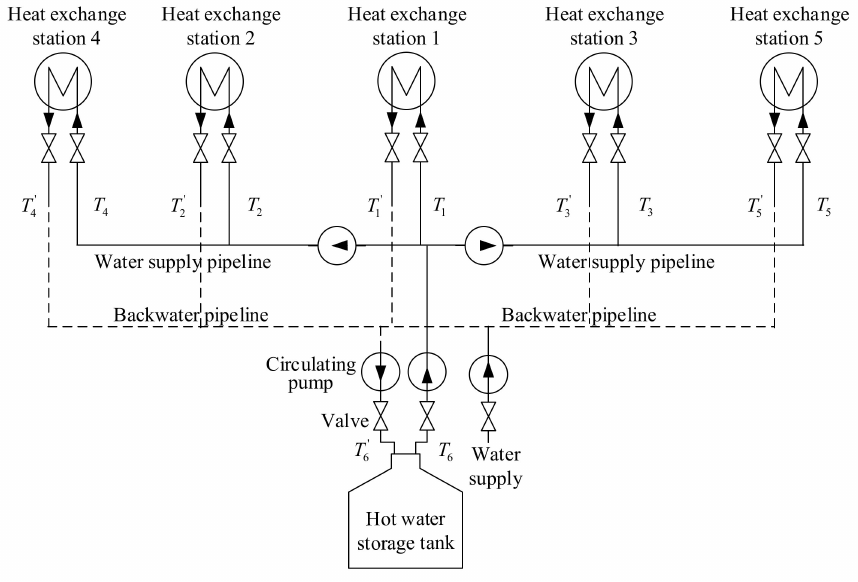
Figure 6. Pipe network diagram of a heating supply